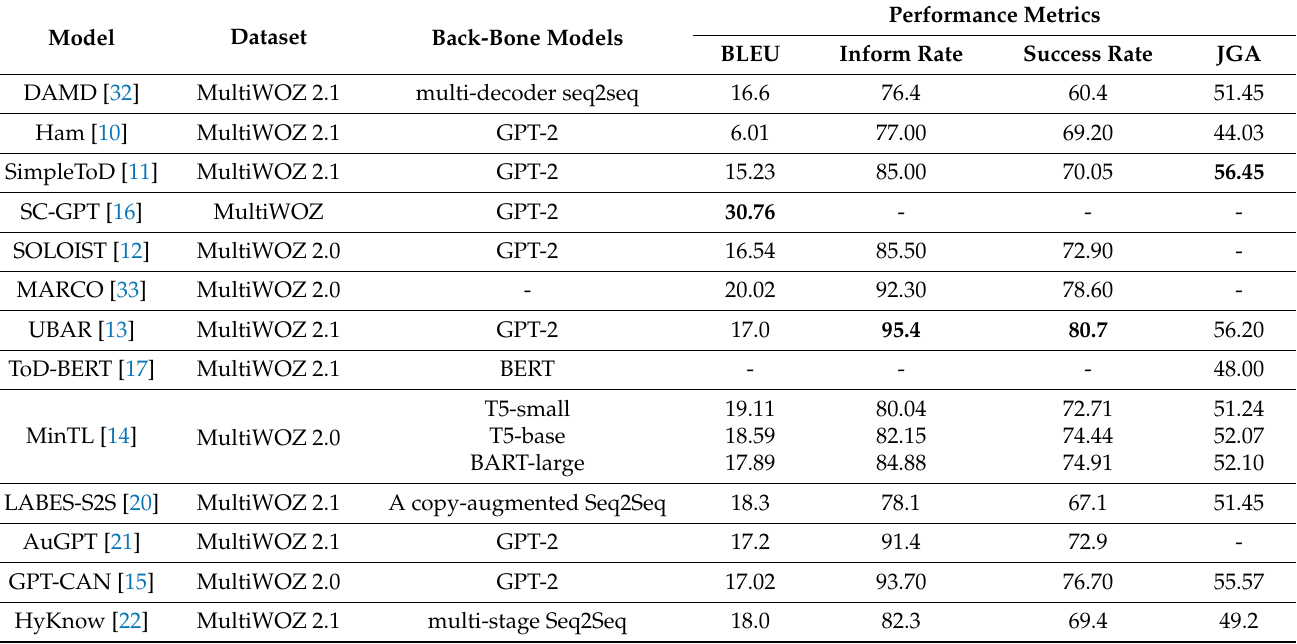
Table 1. Comparing the performances of the most common English-based task-oriented dialogue systems (DS). Bold numbers indicating the best system according to the column’s metric